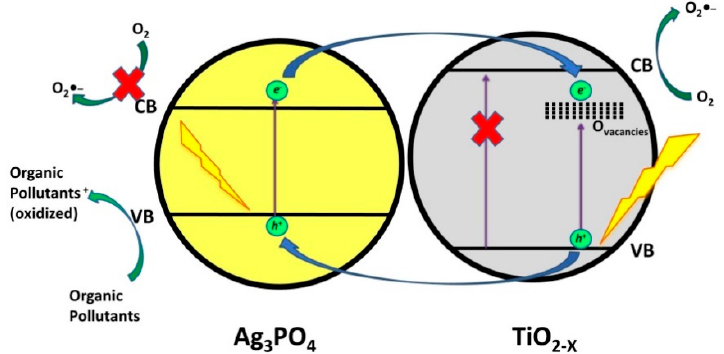
Figure 9. Photocatalytic reaction mechanism of TiO 2 − X /Ag 3 PO 4 under visible light irradiation. Silver oxide (Ag 2 O), a visible light active photocatalyst with band gap of 1.2 eV, is another silver-based compound with semiconducting properties. Based on the band positions (VB and CB), it represents a promising matching candidate to form heterojunctions with TiO 2 ( Type III Heterojunction ). Hence, photocatalytic degradation of levofloxacin (LEV) using Ag 2 O/TiO 2 quantum dots is reported with the maximum of 81% LEV degradation within 90 min. of visible light irradiation [27]. Based on the proposed mechanism under visible light illumination (Figure 10), upon excitation of Ag 2 O, e − / h + pairs are formed, whereas TiO 2 is not activated due to its wide band gap. Photogenerated e − in the CB of Ag 2 O were transferred to CB of TiO 2 and involved in reactions with adsorbed O 2 forming O 2 ●‒ that participated in LEV degradation. In addition, photogenerated h + in VB of Ag 2 O yielded the formation of •OH, through reactions with OH − , and participated in LEV degradation as well. The authors employed LC-MS analysis to elucidate LEV degradation pathway and, as such, establish the role of formed ROS. Hence, parent compound LEV underwent decarboxylation of the acetyl group; hydroxylation resulting in the formation of quinolone moieties; demethylation and the subsequent addition of hydrogen atom generating modifications at piperazine ring; while successive •OH attack resulted in multi-hydroxylated intermediates. Such findings confirmed the dominant role of •OH in LEV degradation. Figure 10. Photocatalytic degradation mechanism over TiO 2 /Ag 2 O composite. In another study, Gou et al. [28] investigated the application of Ag 2 O/TiO 2 /zeolite composite for solar-driven degradation of norfloxacin (NOR) (Table 7). Besides high effectiveness (98.7% NOR degradation and 83.1% mineralization of organic content within 60 min. treatment), they elucidated the NOR degradation pathway, involving in the initial stage decarboxylation, defluorination or